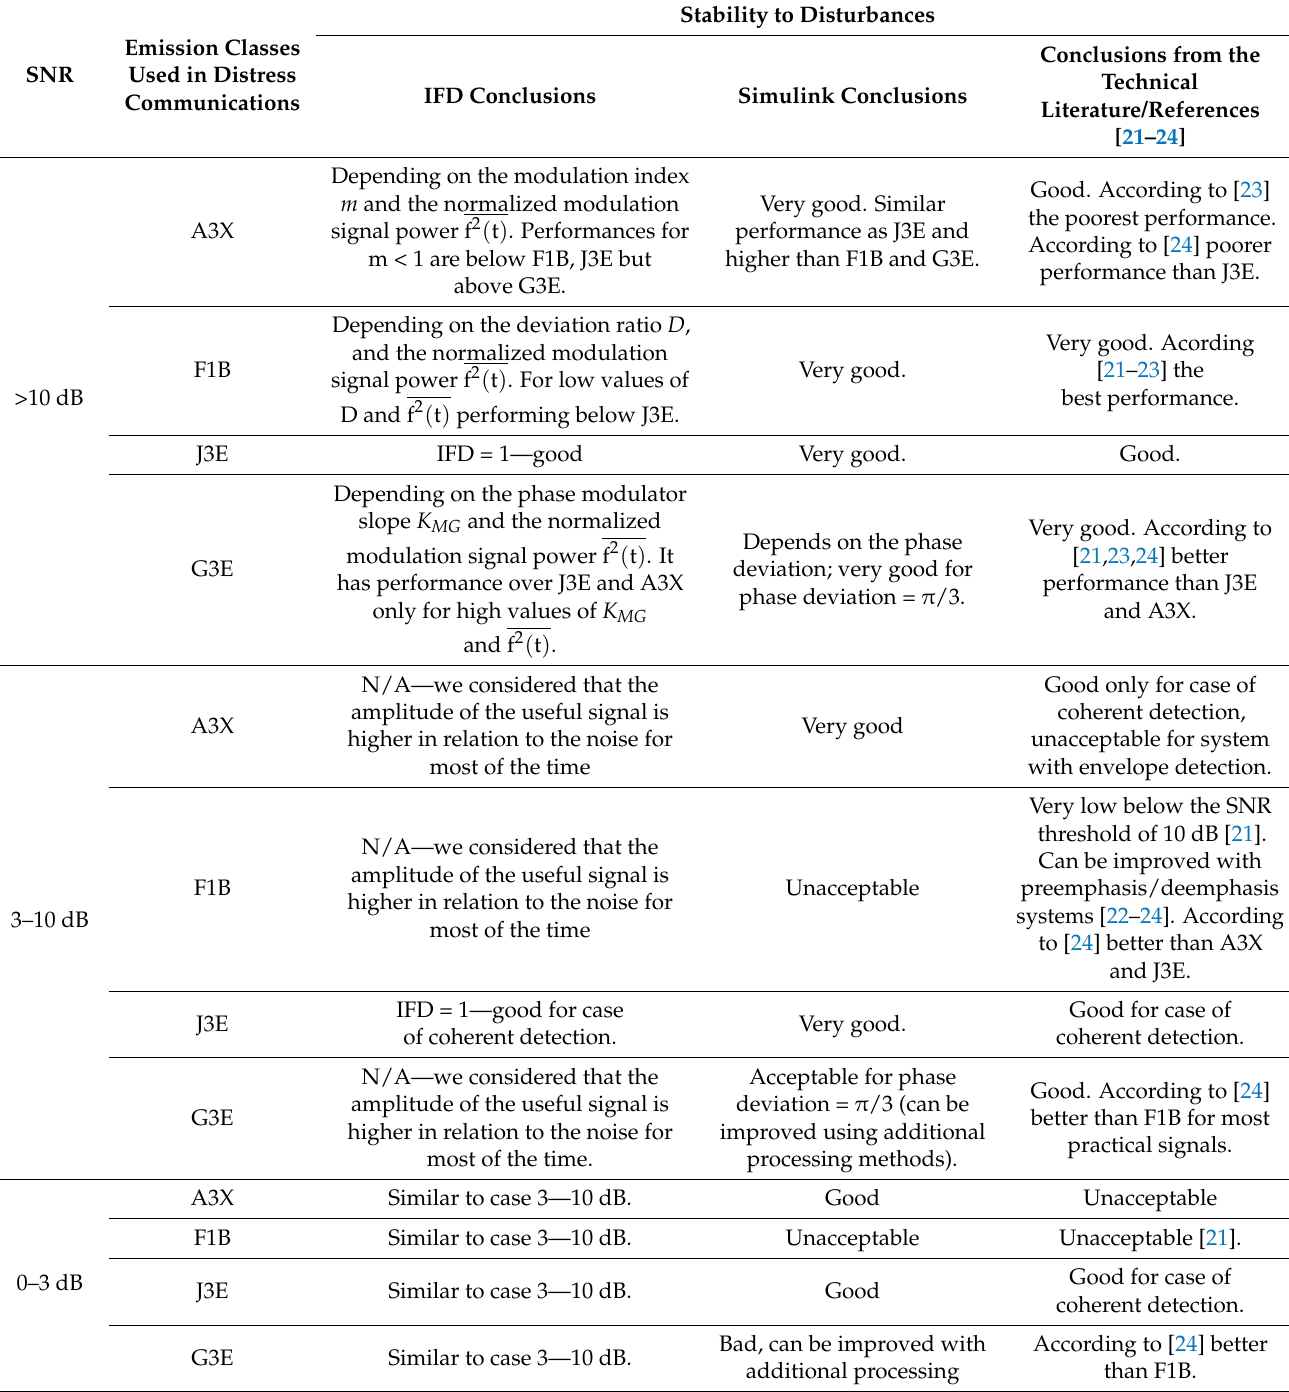
Table 1. Comparison of analog system stability to disturbance results obtained from both research method and from technical